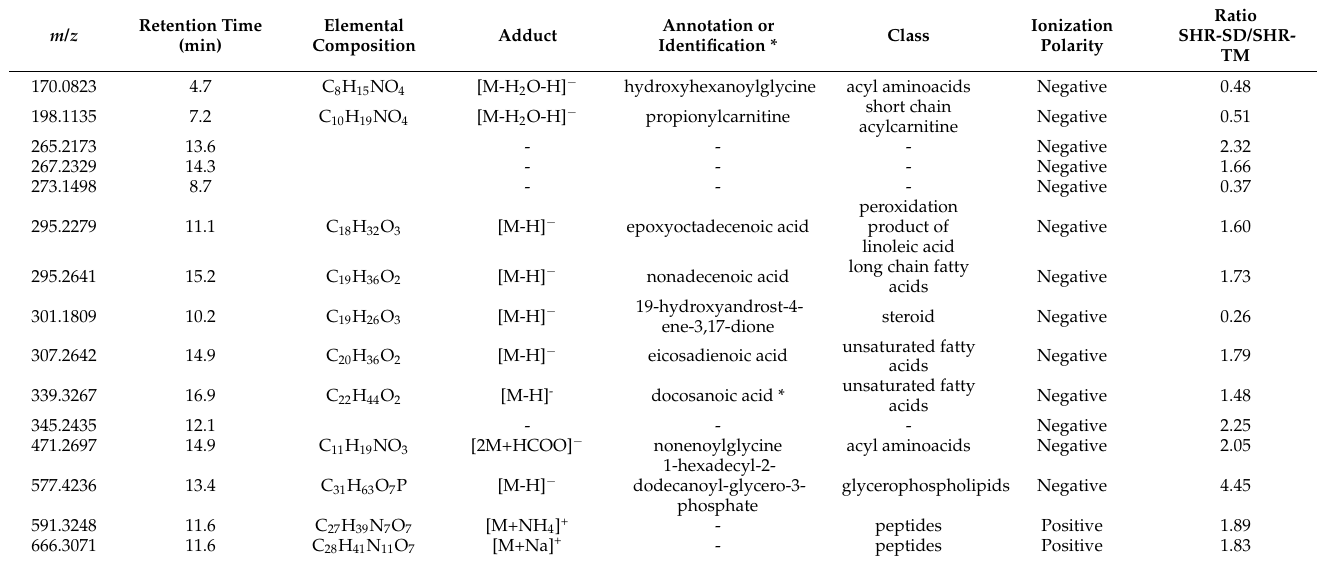
Table 1. List of metabolite targets of Tenebrio molitor protein extract intervention. Measured m / z value, chromatographic retention time, elemental composition, adduct, annotation, class of metabolite, ionization polarity, and relative intensity value (i.e., SHR-SD/SHR-TM ratio) are reported for each detected